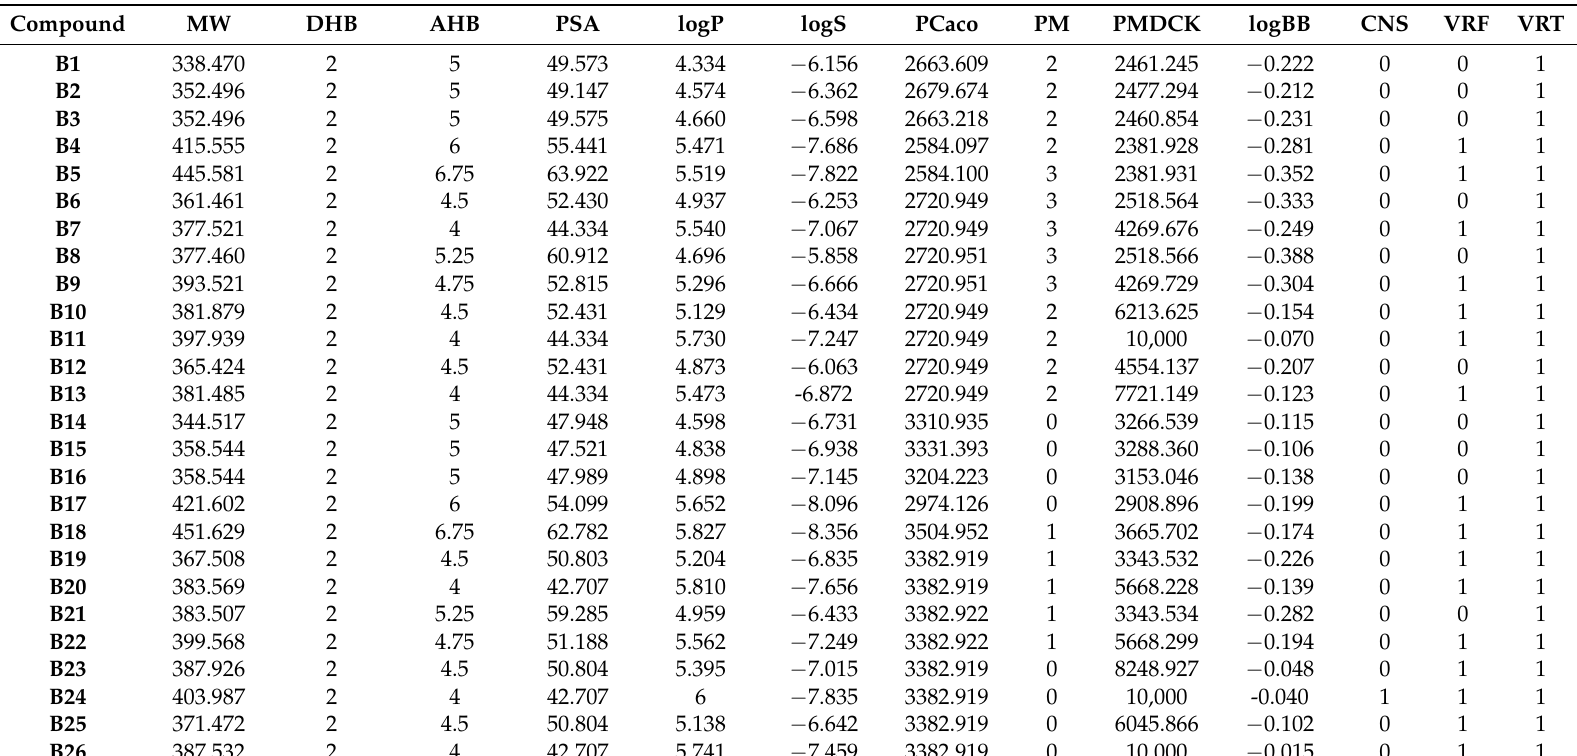
Table 2. Calculated Absorption, Distribution, Metabolism, and Excretion (ADME) parameters of compounds B1 – B26